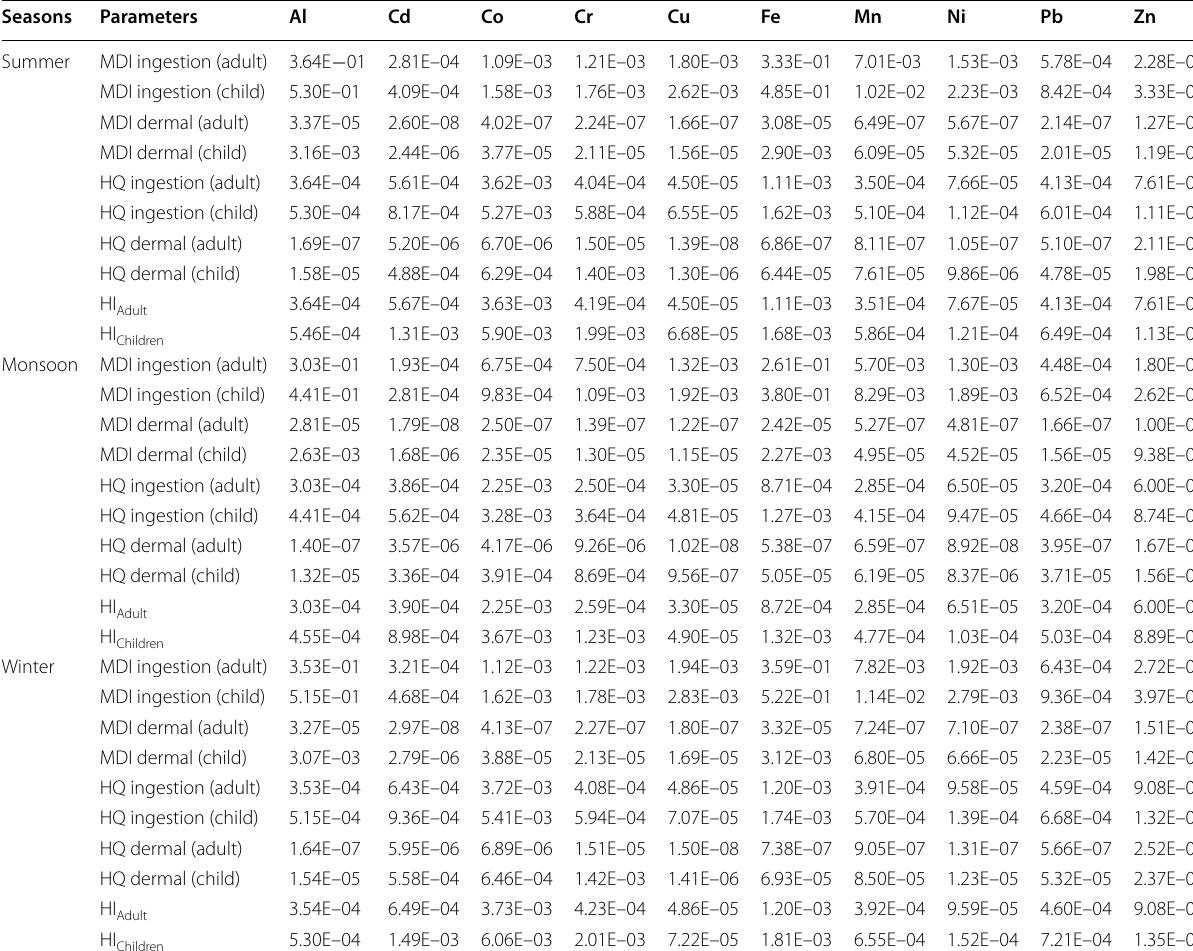
Table 3 Seasonal MDI (adult and child), MDI (adult and child), HQ (adult and child), and HI (adult and ingestion dermal